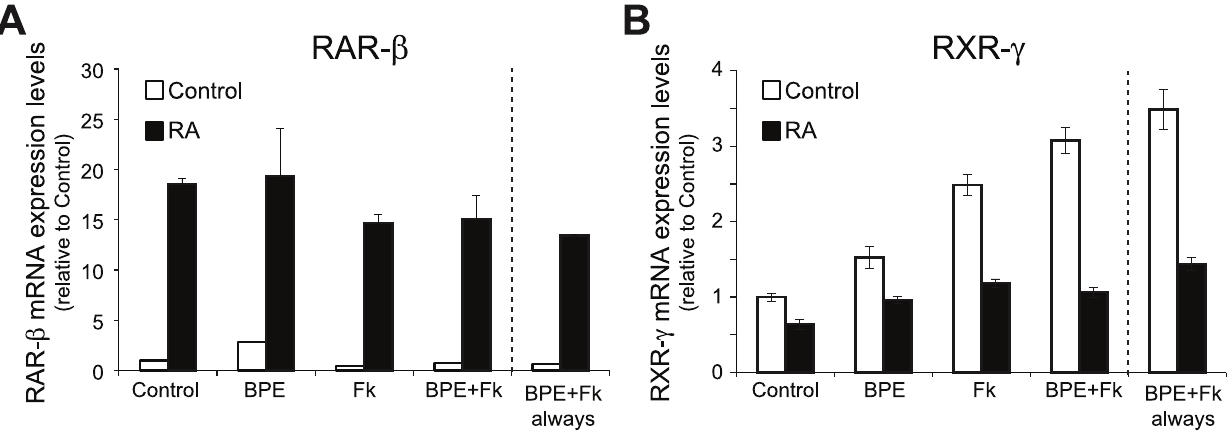
Figure 6. Influence of axonal contact mimickers on RXR- c and RAR- b regulation by RA. RXR- c downregulation is higher in the presence of axonal contact mimickers, while RAR- b upregulation was similar irrespective of the growth conditions. Isolated SCs were adapted for 24 hours to the absence of the axonal contact mimickers BPE and forskolin and subsequently treated for 48 hours with 1 m M RA in the presence or absence of 2 m M forskolin, 60 m g/ml BPE or the combination of both, and the mRNA levels of RAR- b ( A ) and RXR- c ( B ) were analyzed by Q-RT-PCR. In all instances, the levels reached after the acute combined treatment were compared to SCs continuously grown in the presence of BPE and Fk (BPE + Fk always). All values are shown as the mean 6 SEM relative to their respective controls.